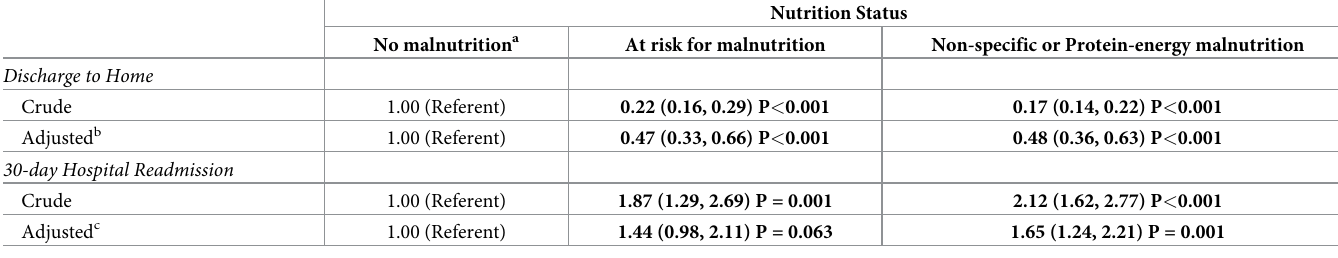
Table 5. Unadjusted and adjusted associations between nutrition status and post-discharge outcomes (n =